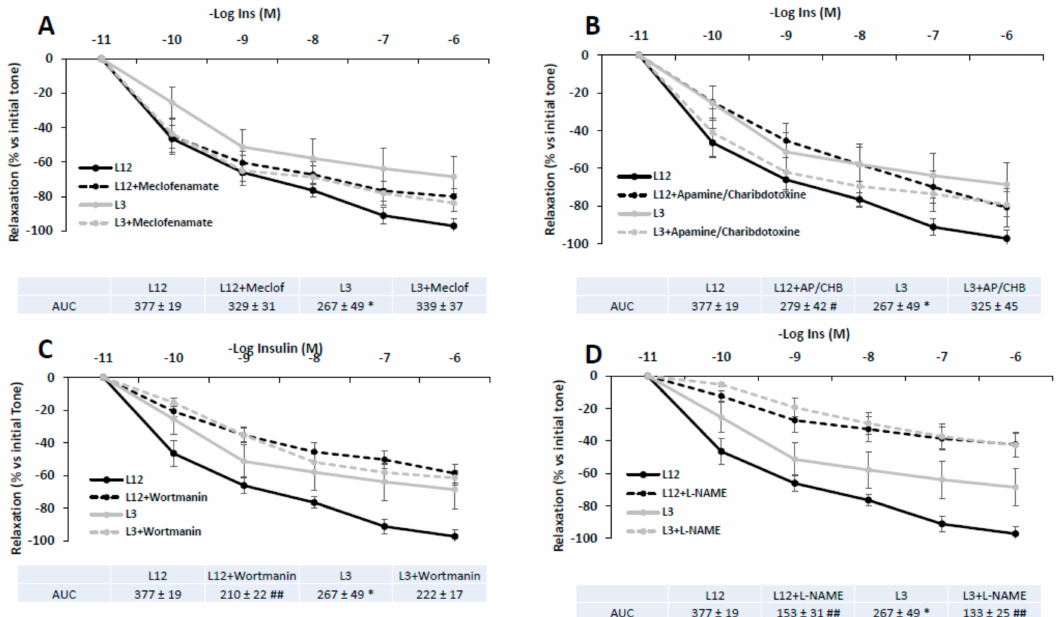
Figure 6. Relaxation in response to insulin (10 − 11 –10 − 6 M) of precontracted aortic rings from rats raised in L12 or L3 litters in the absence or in the presence of A ) the cyclooxygenase inhibitor meclofenamate (10 − 5 M), B ) the potassium channels blockers apamin (10 − 6 M) plus charybdotoxin (10 − 7 M), C ), the PI3K inhibitor wortmanin (10 − 7 M), and D ), the nitric oxide synthase inhibitor L-NAME (10 − 4 M). Note: * p < 0.05 di ff erence between aortic rings from L3 and L12; # p < 0.05; ## p < 0.01 di ff erence between aortic rings incubated with the blockers and control. Values are expressed as percentage of initial tone and represented as mean ± SEM; n = 6–13 rats / experimental group. Data were analyzed by two-way ANOVA followed by Bonferroni post-hoc